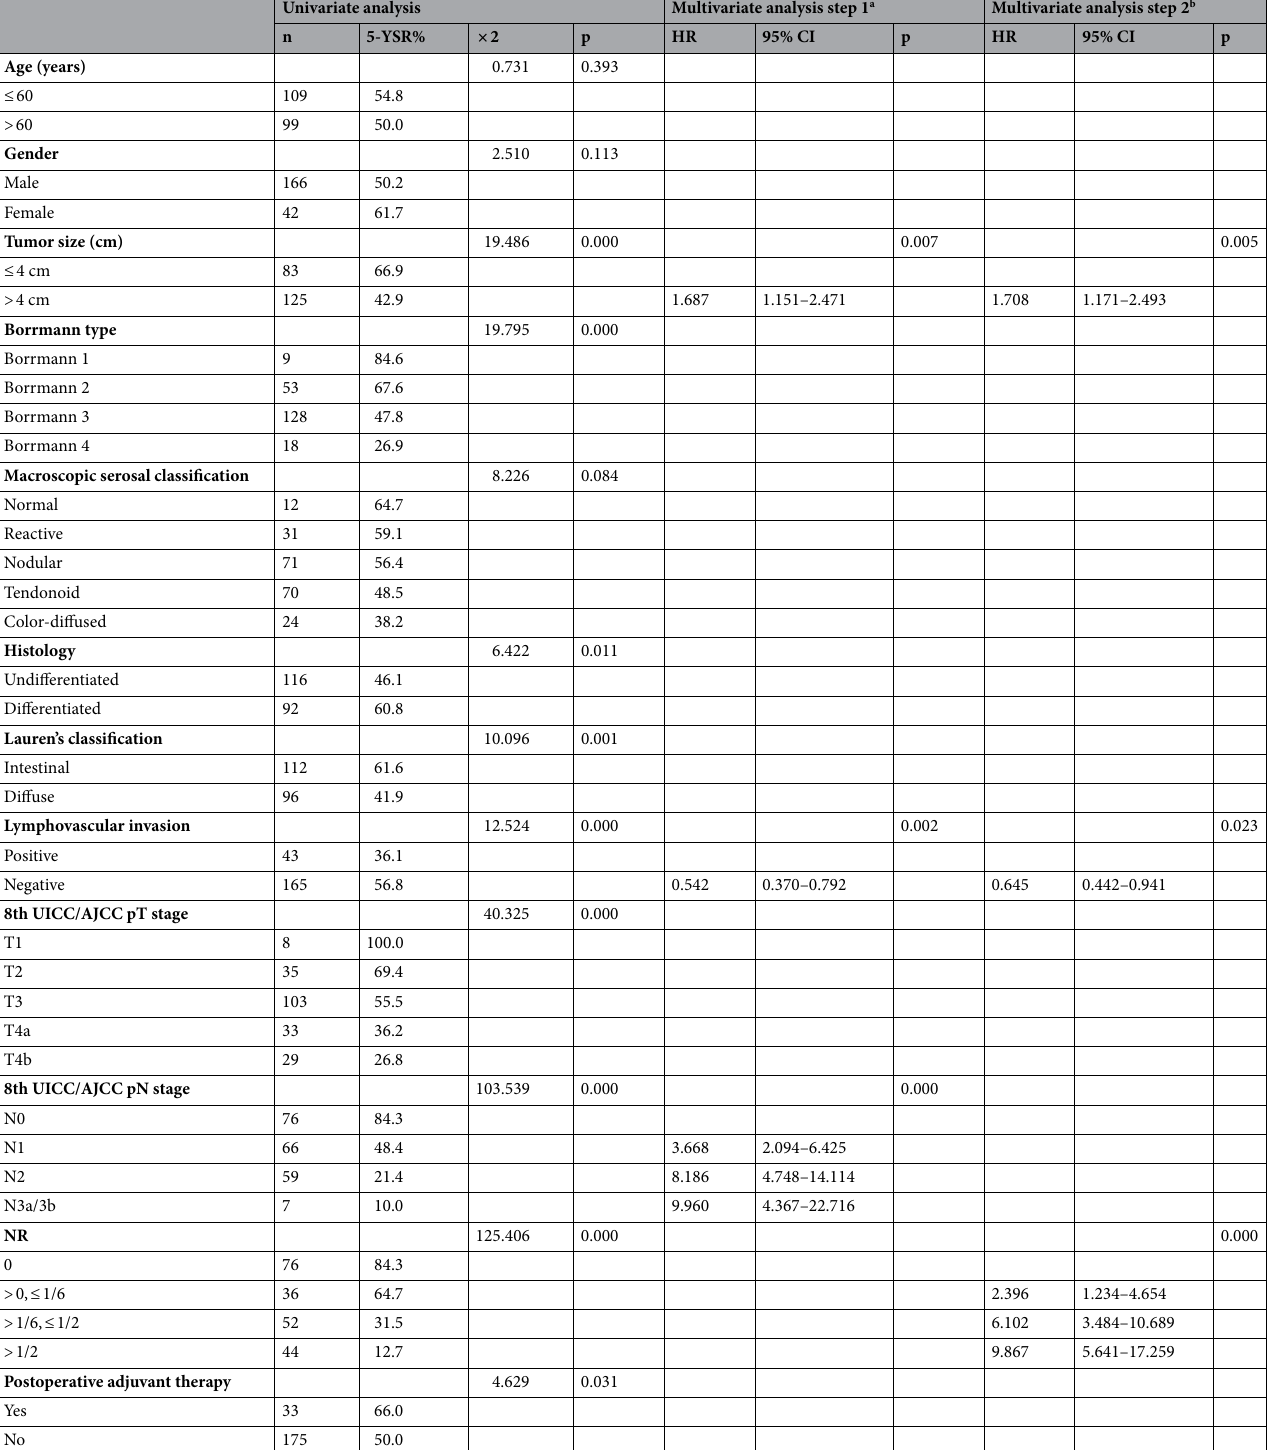
Table 2. Univariate analysis and two-step multivariate analysis for overall survival. 5-YSR 5-year survival rate, UICC union for international cancer control, AJCC American joint committee on cancer, HR hazard ratio, CI confidence interval, NR lymph node ratio. a Step 1, with consideration of all significantly important prognostic factors in the univariate analysis, with the exception of the revised NR stage. b Step 2, with consideration of all significantly important prognostic factors in the univariate analysis, including the revised NR